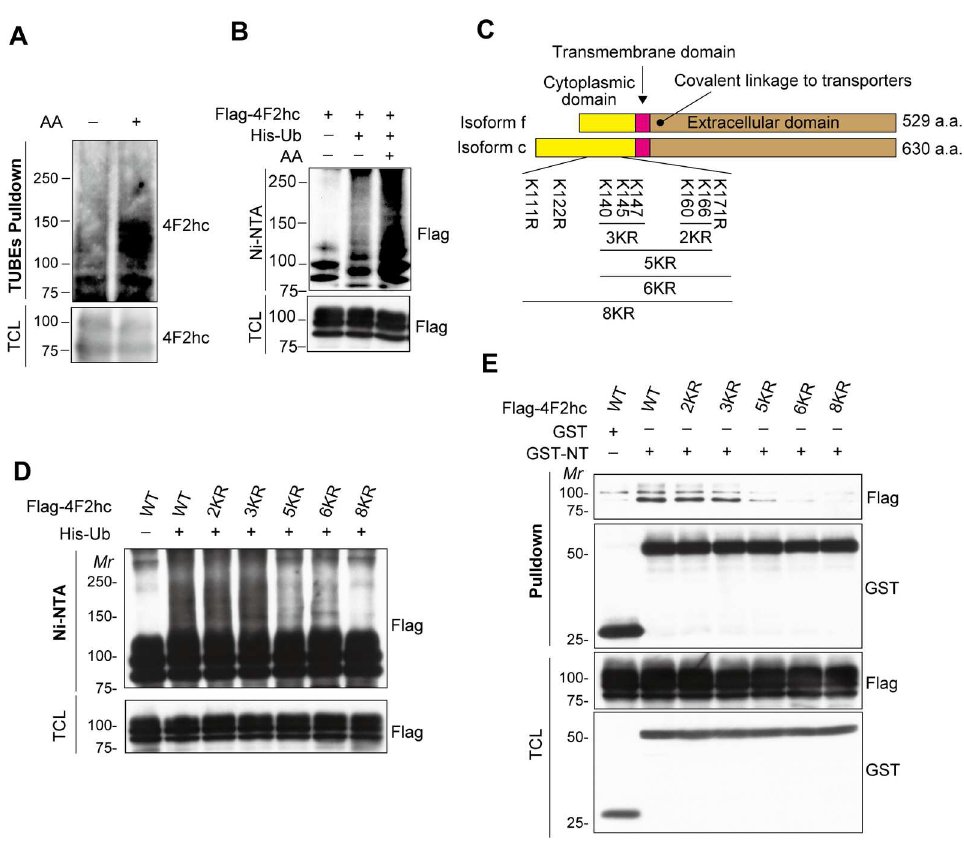
Fig 3. 4F2hc/Girdin complex is modulated by ubiquitination of 4F2hc. (A and B) 293FT cells transfected with the indicated plasmids were starved for amino acids for 1 h in amino acid–free medium supplemented with dialyzed FBS, followed by stimulation with complete growth medium for 30 min. Ubiquitinated proteins were isolated with glutathione-sepharose beads under a non-denaturing condition (A) or Ni-NTA agarose beads under a denaturing condition (B) to detect 4F2hc ubiquitination. (C) Primary structures of 4F2hc (short and long isoforms) and its mutants used in the study. (D) Lysates from 293FT cells transfected with the indicated plasmids were pulled down under denaturing conditions using Ni-NTA agarose beads, showing the ubiquitination of the transfected 4F2hc and its mutants. (E) 293FT cells transfected with the indicated combinations of 4F2hc, GST, and GST-NT. The lysates were pulled down with glutathione beads, followed by WB with the indicated antibodies. a.a., amino acids; FBS, fetal bovine serum; Girdin, girders of actin filaments; GST, glutathione S-transferase; His-Ub, histidine-tagged Ub; Mr , molecular marker; TUBE, tandem-repeated ubiquitin-binding entity; WB, western blot; WT, wild-type; 4F2hc, 4F2 heavy chain.